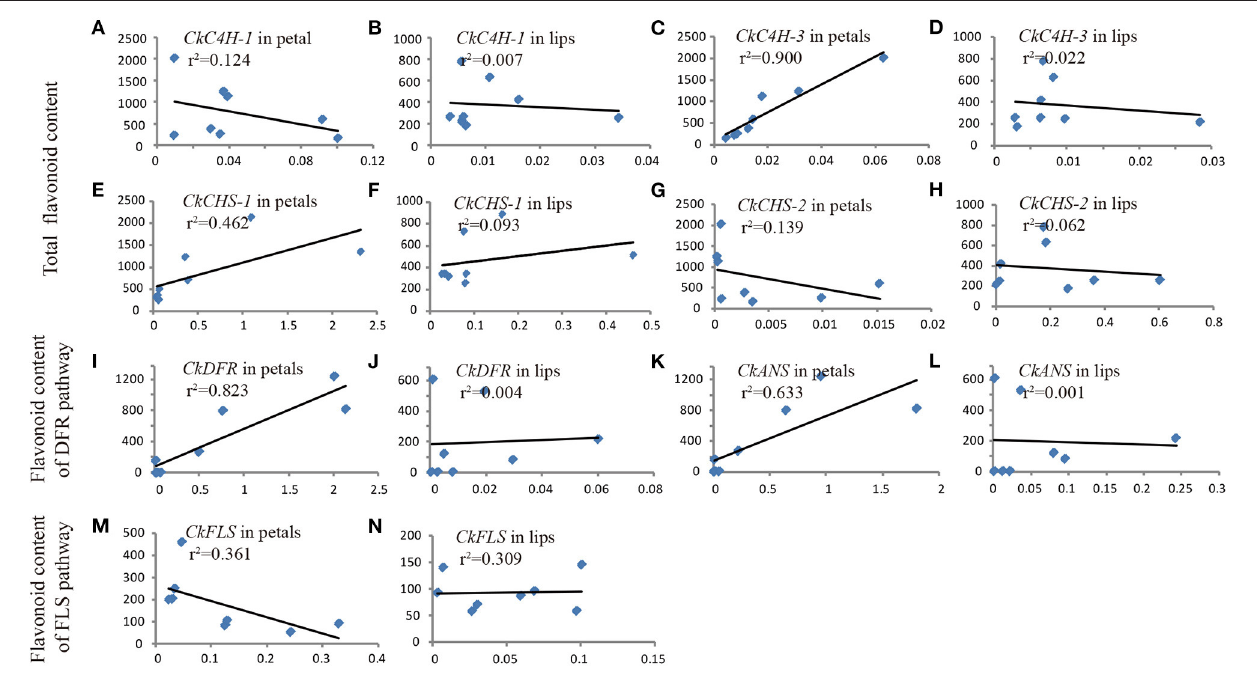
FIGURE 6 | Pearson’s correlation coefficient between gene transcript level (X-axis) and flavonoid content (Y-axis) in petals (A,C,E,G,I,K,M) and the lip (B,D,F,H,J,L,N) of C. kanran . Total flavonoids included MY, KA, QU, PEO, MA, and CY. The anthocyanidins of the DFR pathway included PEO, MA, and CY. The flavonol of the FLS pathway included MY, KA, and QU.